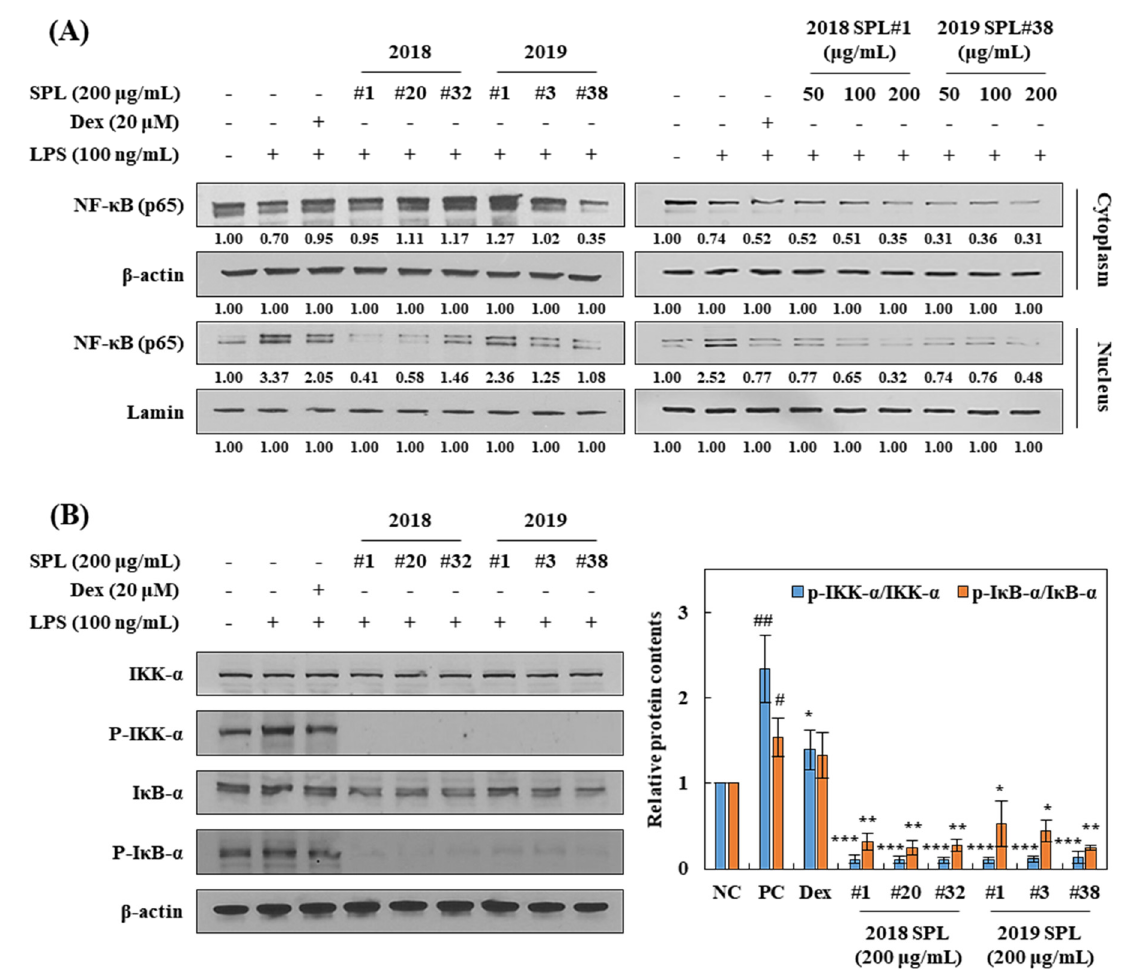
Figure 4. Effects of SPL extracts on nuclear factor (NF)- κ B translocation in RAW 264.7 cells. Cells were pretreated with 200 µ g/mL of SPL extracts and dexamethasone (20 µ M) for 2 h. After pretreatment, cells were treated with LPS (100 ng/mL) for 6 h. To identify NF- κ B protein expression in cytoplasm and nuclear, fractions were separated by NE-PER nuclear- cytoplasmic reagent kit. ( A ) Cytoplasm and nucleus NF- κ B expression of 6 kind of SPL extracts was determined by Western blotting analysis according to cultivars and concentration. ( B ) IKK- α and I κ B- α proteins were analyzed by Western blotting with 2 h pretreatment of SPL and dexamethasone, and 1 h treatment of LPS. Relative protein contents were quantified by Image J program. Data are presented as mean ± SEM. Significant differences are compared with control at # p < 0.05, ## p < 0.01, and PC at * p < 0.05, ** p < 0.01, *** p < 0.001 ( n = 2).